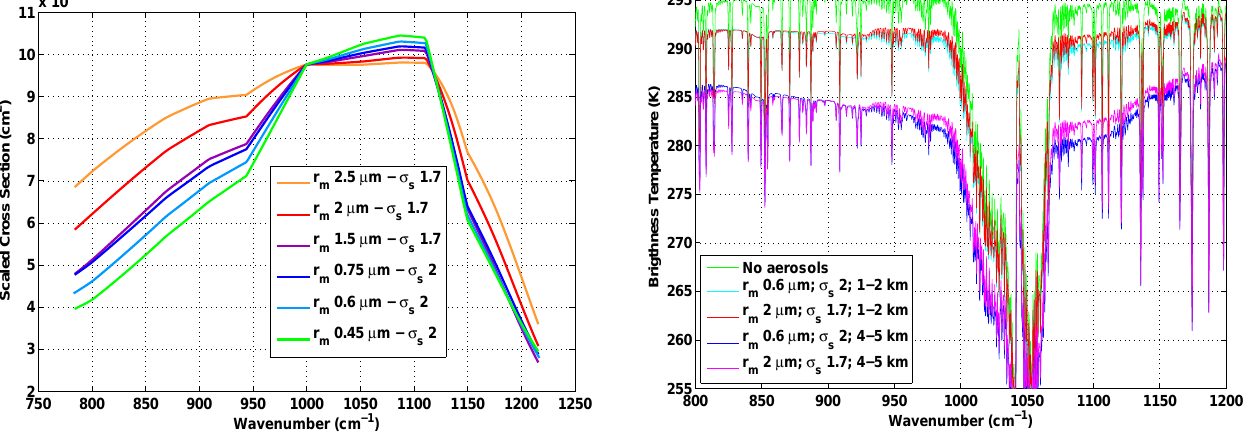
Fig. 2. Extinction cross sections computed using a Mie code, for different log-normal particle number size distributions and the dust refractive index from the GEISA-HITRAN databases. The cross sections have been scaled at 1000cm − 1 , with the following mul- tiplicative factors (from biggest to smallest particles): 1–1.7–3.5– 13–25–64.